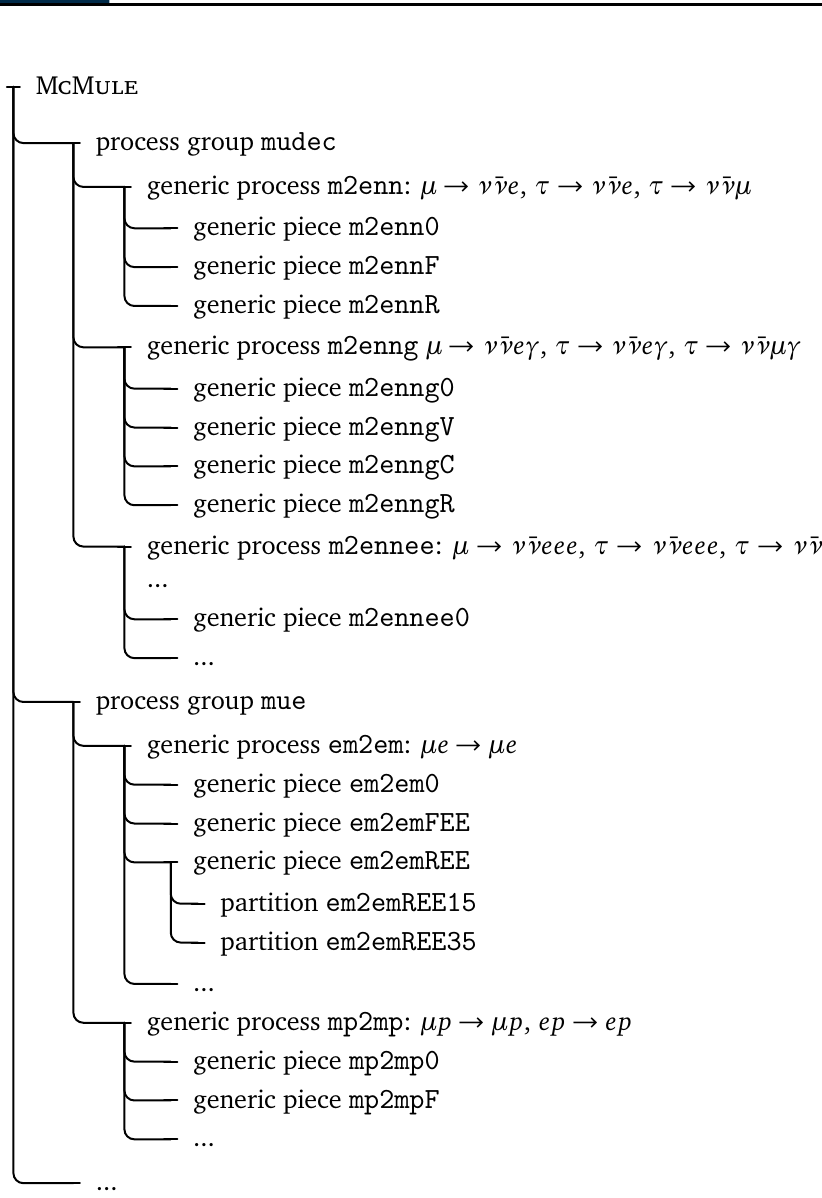
Figure 2: The structure of process group, generic process, and generic piece as used by McMule. The suffices 0 , V , C , F , R , and others are explained in more detail in Section